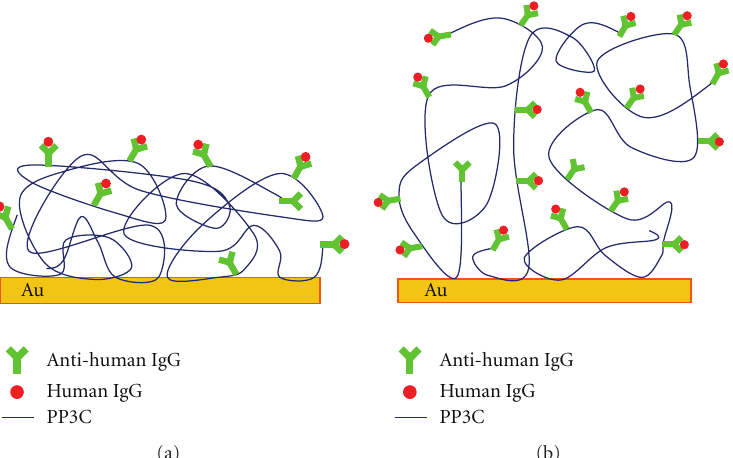
Figure 5: Schematic diagram of the binding process of anti-human IgG to human IgG on PP3C film (a) without applying potential and (b) with applying potential